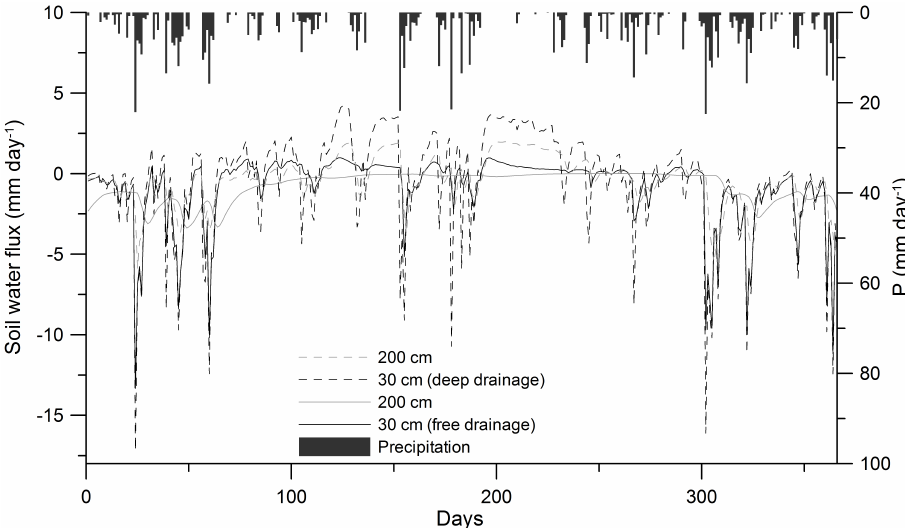
Fig. 5. One-year time series of precipitation and simulated water flux at 30 cm (maximum rooting depth) and 200 cm depth in the Zcg soil profile for the DO climate class (Dessel), showing the influence of the bottom boundary condition (solid lines: free drainage; dashed lines: deep drainage). Negative flux is downwards and positive is upwards in the soil profile.